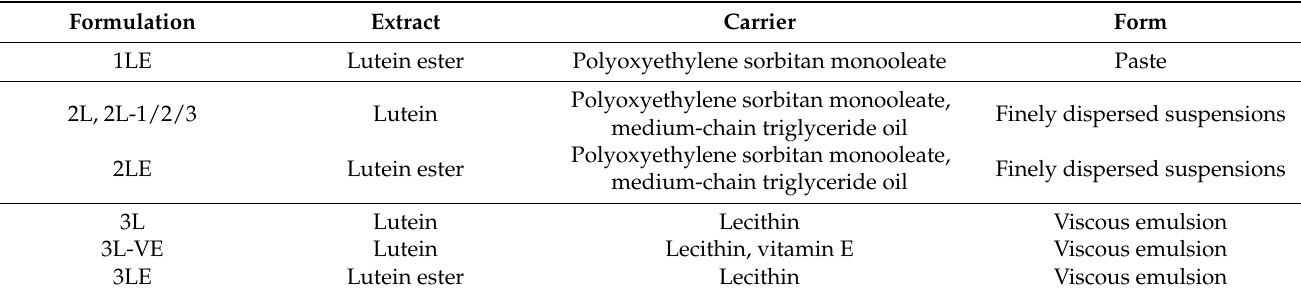
Table 1. Formulations used to protect the lutein (-L suffix) and lutein esters (-LE suffix) in the various food matrices. Formulation Extract Carrier